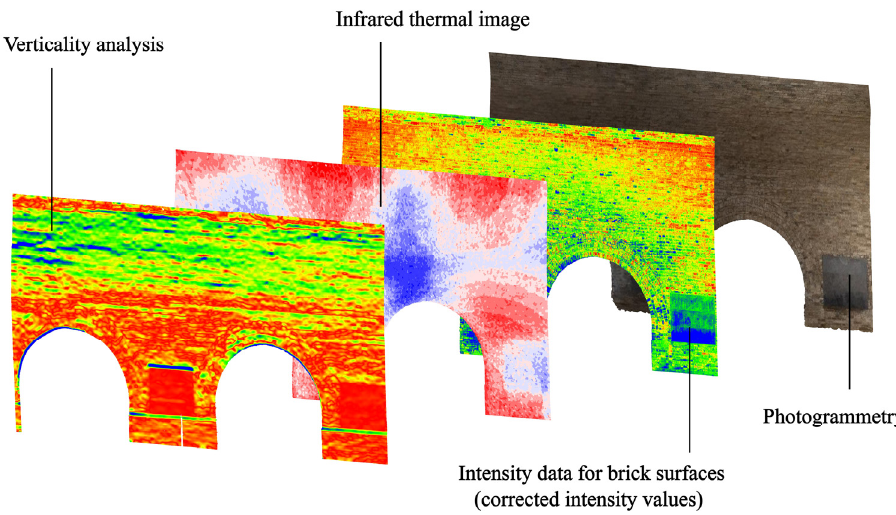
Figure 9. Expression of results using digital measurement technology.